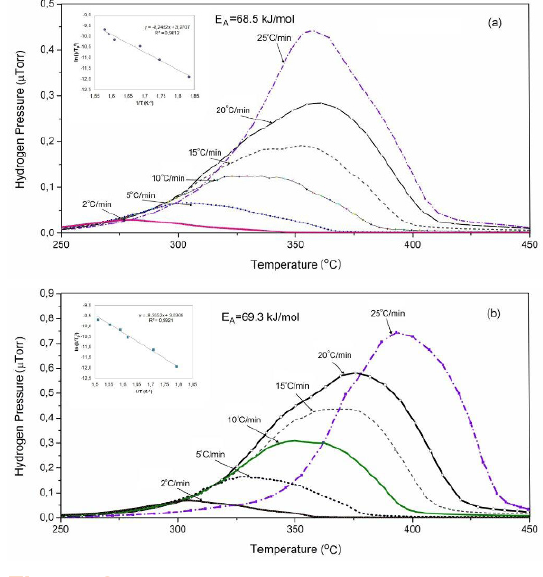
Figure 2. The TPD curves measured with different heating rates for magnesium hydride milled with 7 wt.% of the iron fluorides